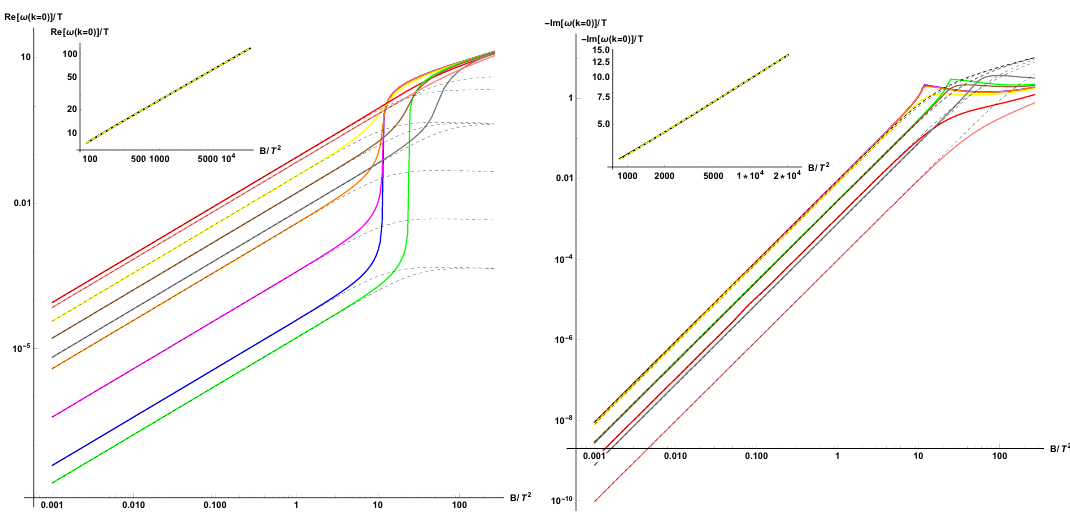
Figure 11 . The cyclotron frequency ! c and the cyclotron damping (cid:13) B extracted from the disper- sion relation of the magnetoplasmon mode at zero momentum. The parameters are f (cid:22)=T; m=T g = ff 0 : 001 ; 0 : 001 g ; f 0 : 01 ; 0 : 001 g ; f 0 : 1 ; 0 : 001 g ; f 1 ; 0 : 001 g ; f 5 ; 0 : 001 g ; f 0 : 001 ; 5 g ; f 1 ; 5 g ; f 1 ; 10 g ; f 10 ; 1 gg (blue, magenta, orange, yellow, red, green, brown, gray, pink). Left: ! c as a function of B=T 2 varying other parameters. The dashed lines are the formula for ! c (5.5) valid at small magnetic (cid:12)eld. The solid lines are the numerical data. The inset shows the large B behavior consistent p with !=T (cid:24) 0 : 84 B=T 2 . Right: The damping (cid:13) B . The dashed lines are the small B analytic formula (5.6). The inset is the large B